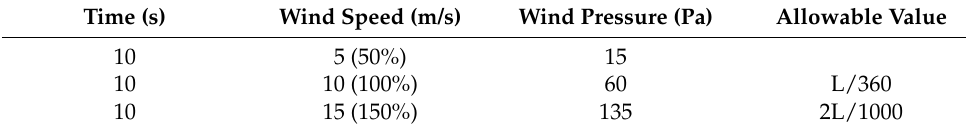
Table 6. Loading protocol #2